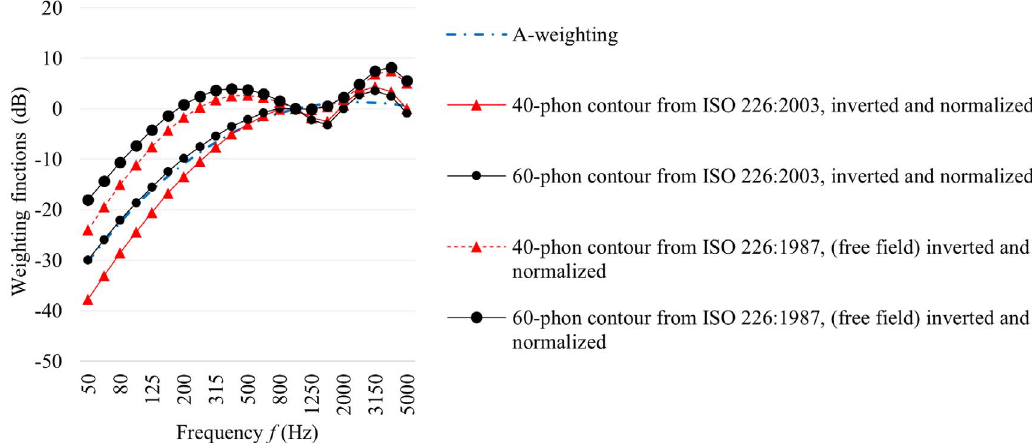
Figure 1. A-weighting compared to equal-loudness-level contours in a pairwise comparison